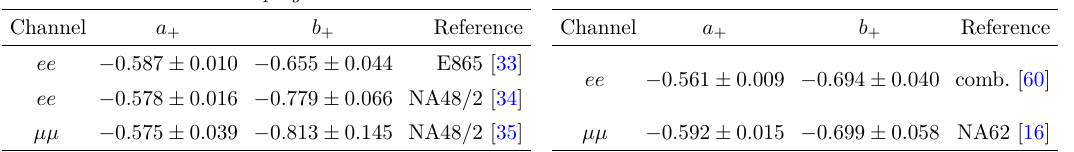
Table 1 . Summary of the estimation of vector form factors for K + → π + ‘ ¯ ‘ . The left panel gives the historical progression and the right panel gives the current